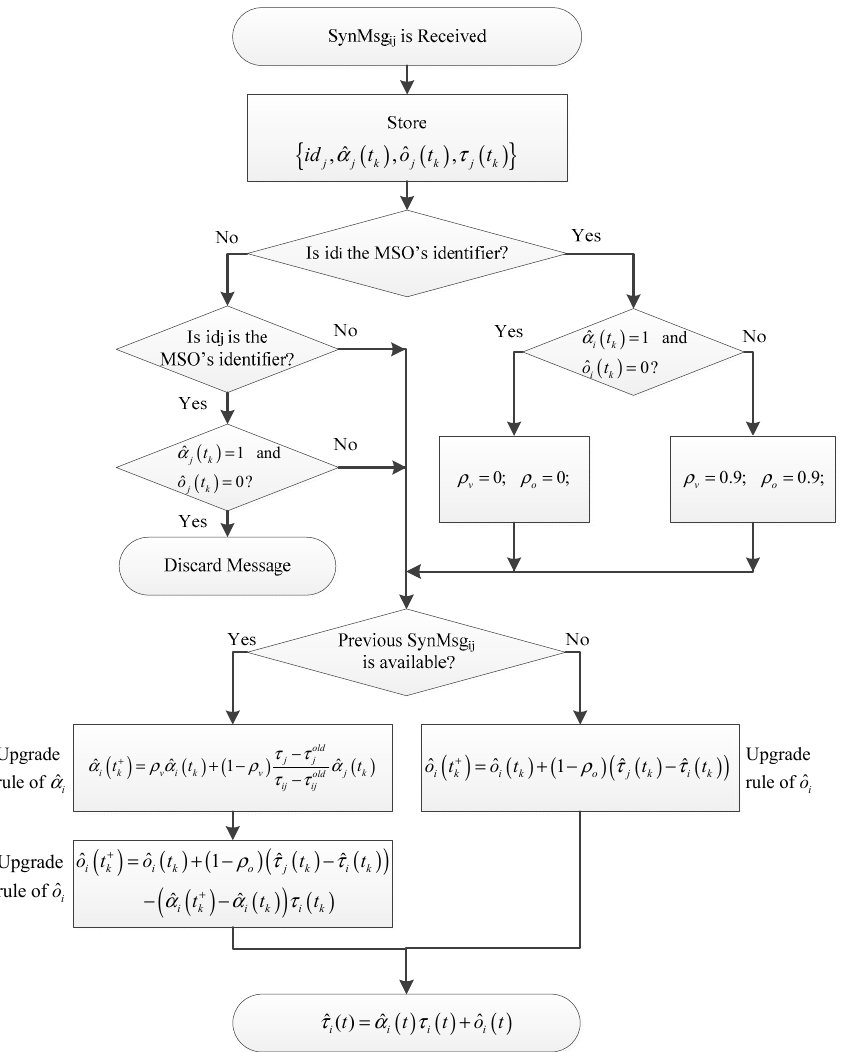
Figure 1. Block scheme of the synchronization procedure executed by the i -th object (SO or MSO), when receiving a SynMsg ij from the j -th object.